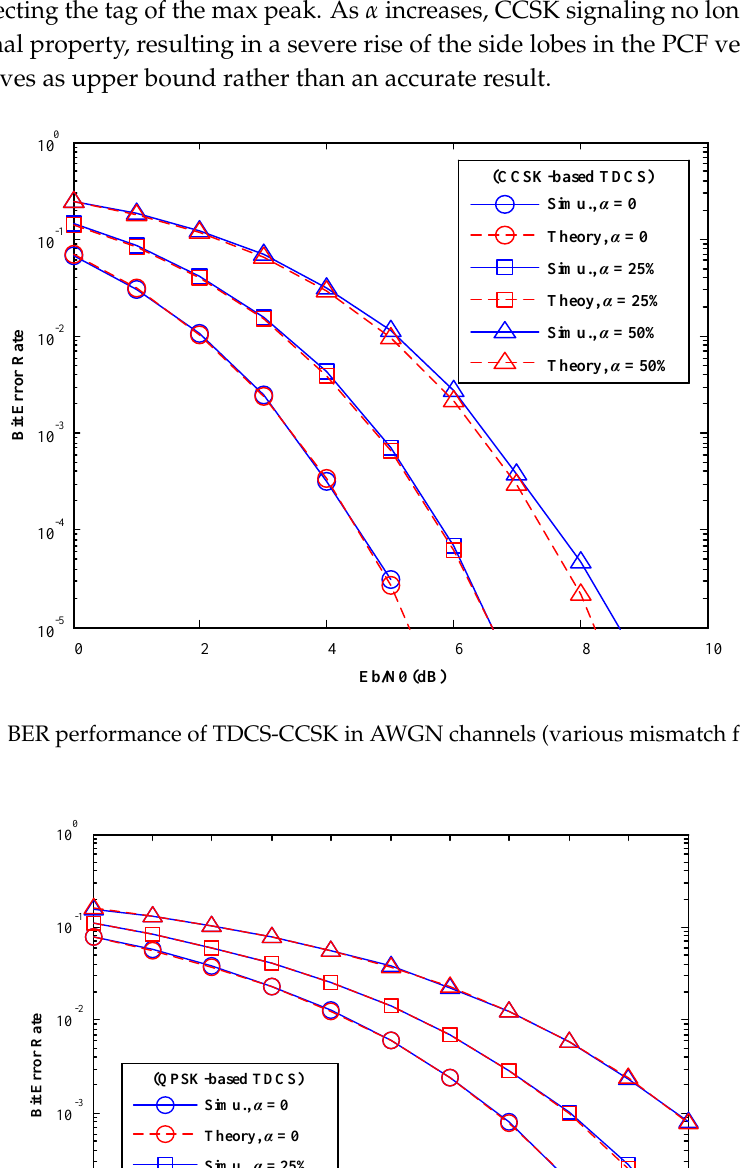
Table 1. Simulation parameters.